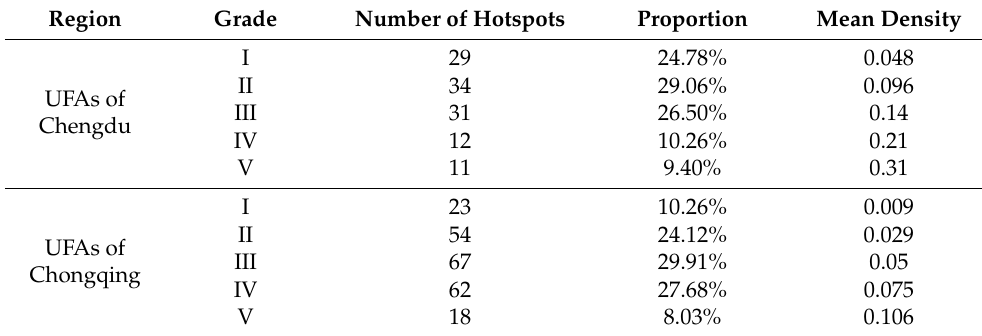
Figure 14. Results of hotspot detection (UFAs of Chongqing). Table 4. Basic information on hotspots of educational resources at different